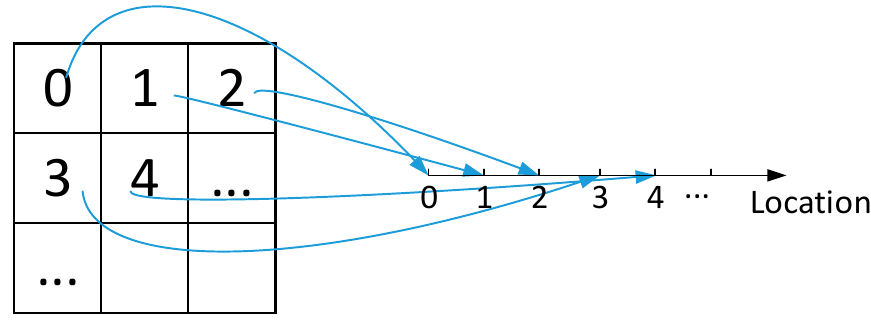
time, respectively.